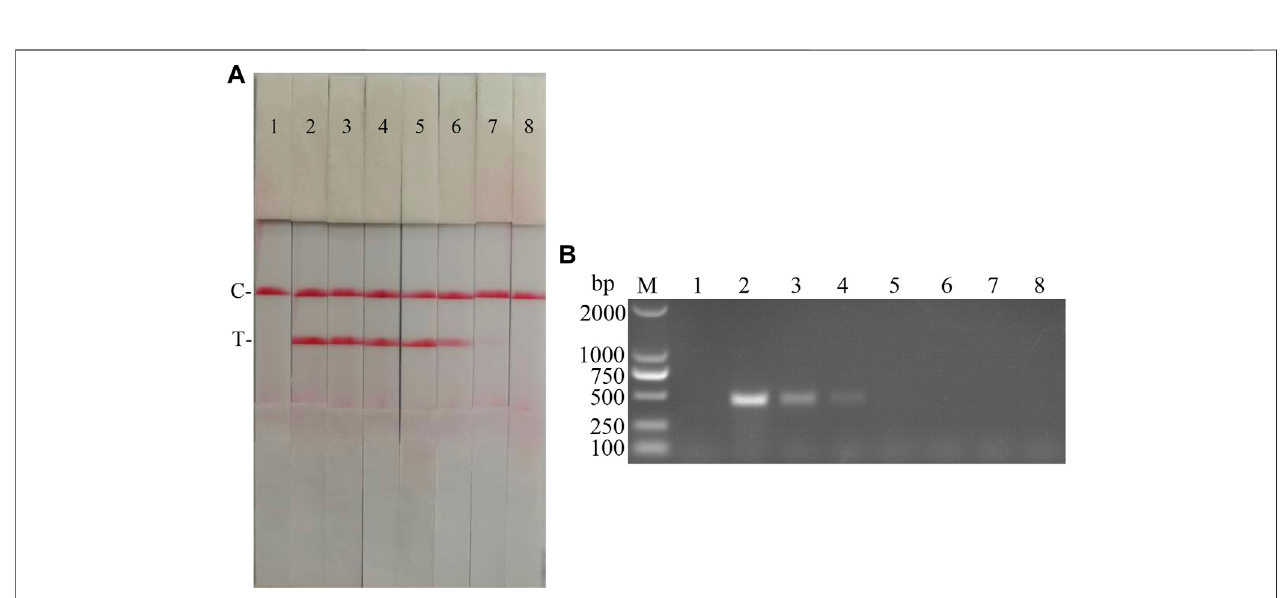
FIGURE 10 | cDNA sensitivity analysis of the CSFV RAA-strip assay. (A) The sensitivity test result of CSFV cDNA by CSFV RAA-strip in order. (B) was that by the conventionalPCRassay.Cisacontrolline.Tisatest line.Misa2,000 bpDNAmarker.Thetemplatesusedinlane1 – 8successivelyare: negativecontrol,1.2 × 10 2 μ